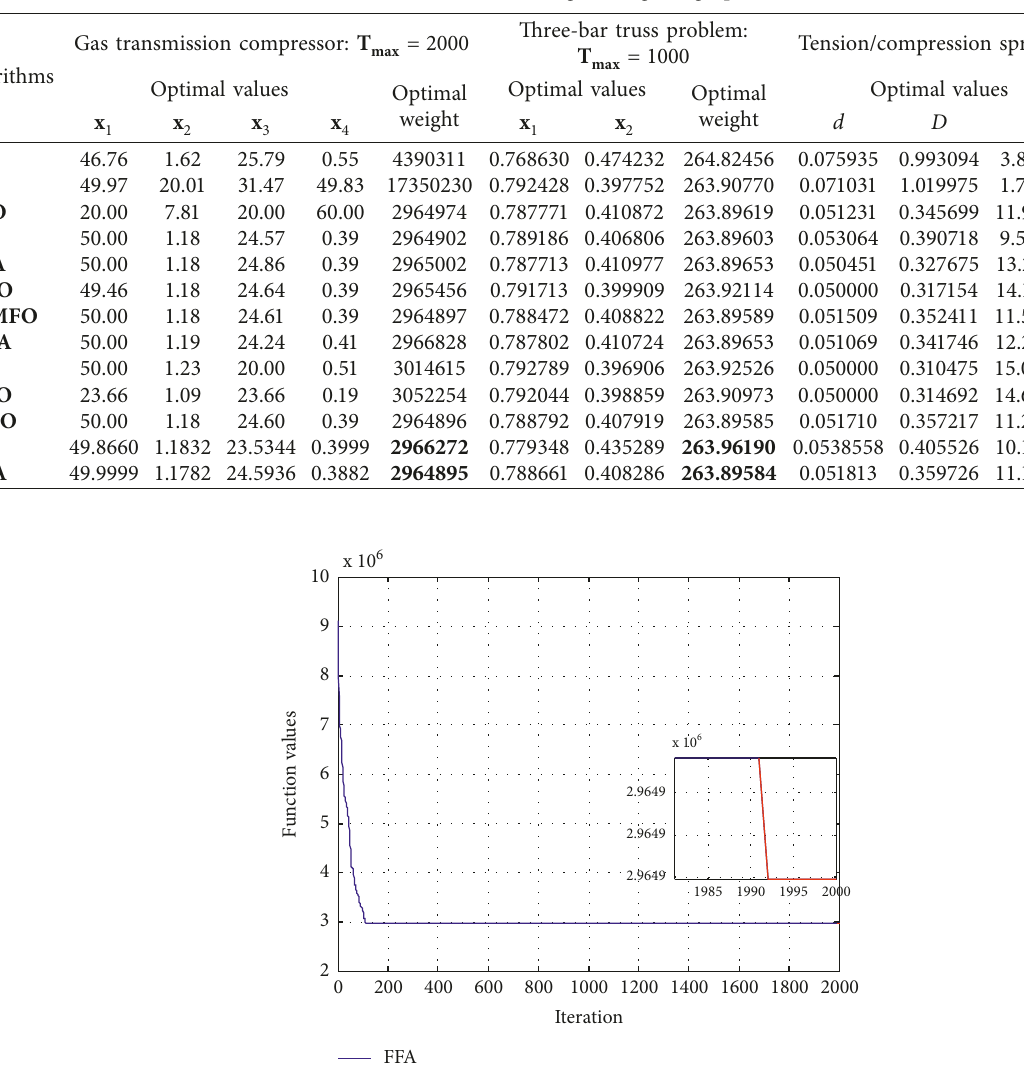
Table 6: Results of the engineering design problems.